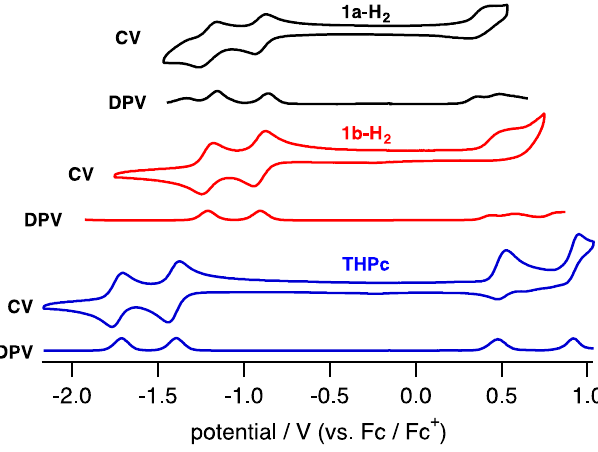
Figure 6. CV and DPV of 1a-H 2 (black), 1b-H 2 (red) and THPc (blue) in CH 2 Cl 2 .